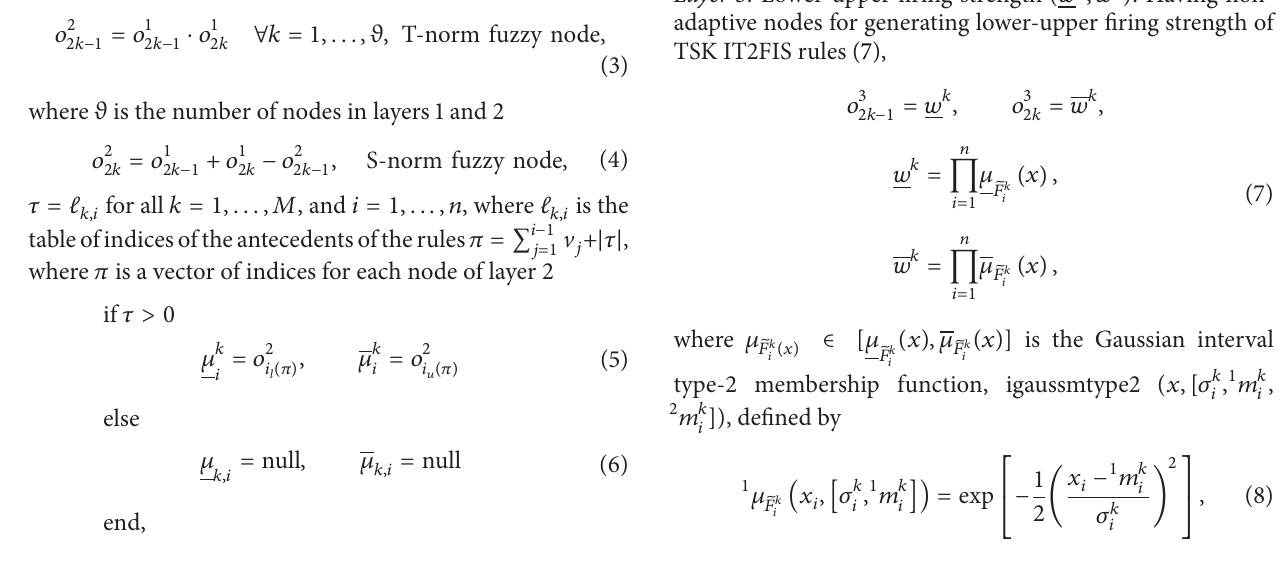
indices of the nodes of layer 2. Layer 3. Lower-upper firing strength (𝑤 𝑘 , 𝑤